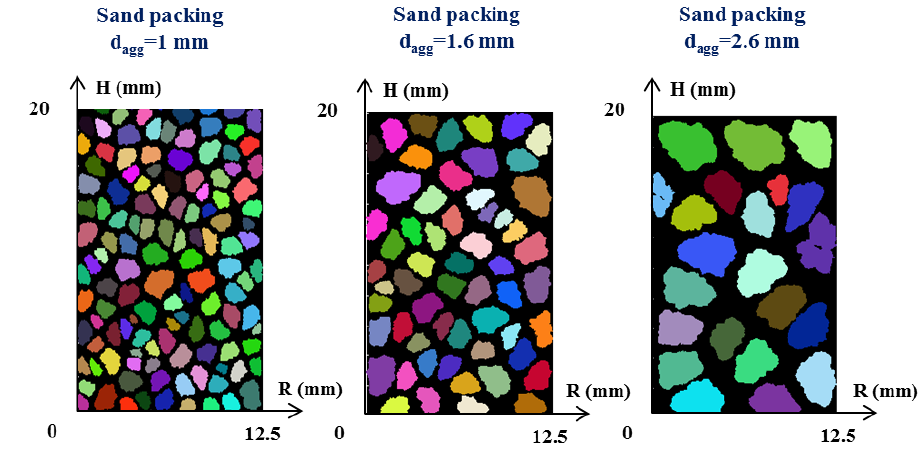
Figure 1. Sand packing (Φ p = 0.46) generated with a Fourier–Voronoi-based generation from the program of Mollon et al. [29].